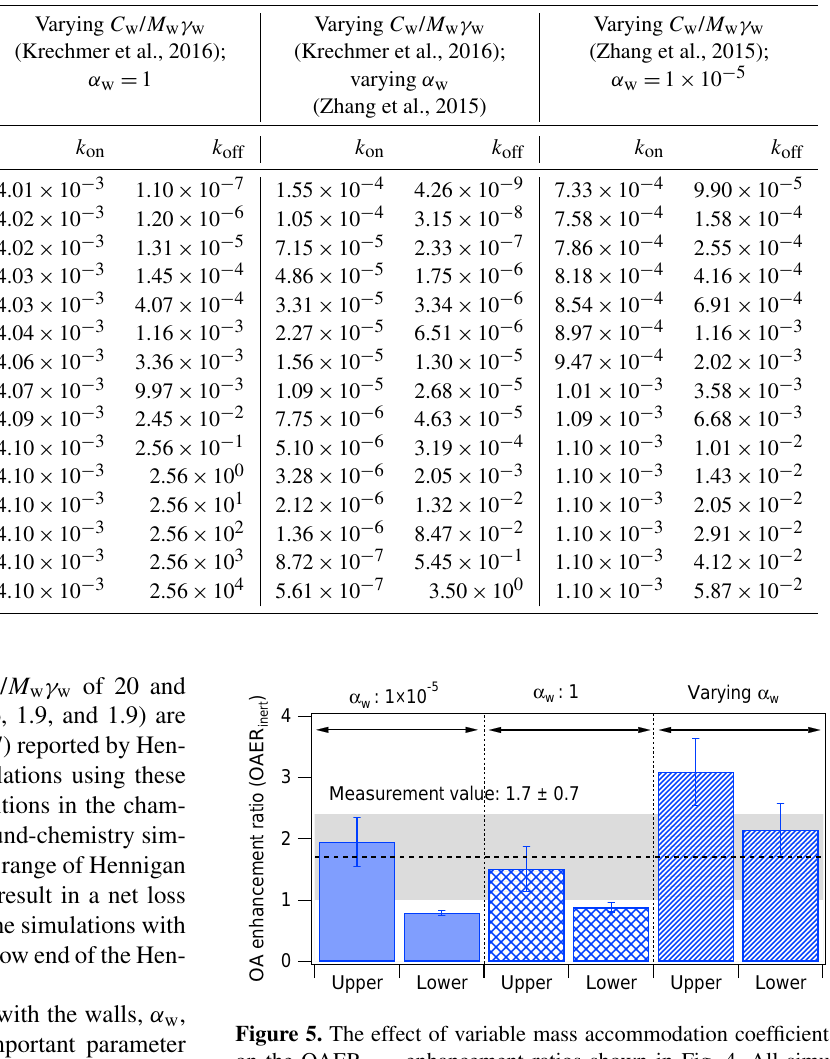
Figure 5. The effect of variable mass accommodation coefficients on the OAER inert enhancement ratios shown in Fig. 4. All simu- lations used varying C w / M w γ w (Krechmer et al., 2016). Results for upper- and lower-bound chemistry assumptions are shown, with assumed α w of 1 × 10 − 5 (solid bars), 1 (gridded bars), and vary- ing α w as a function of C ∗ (striped bars; Zhang et al., 2015). The dashed line and grey area represent the measurement value and its standard deviation from Hennigan et al.